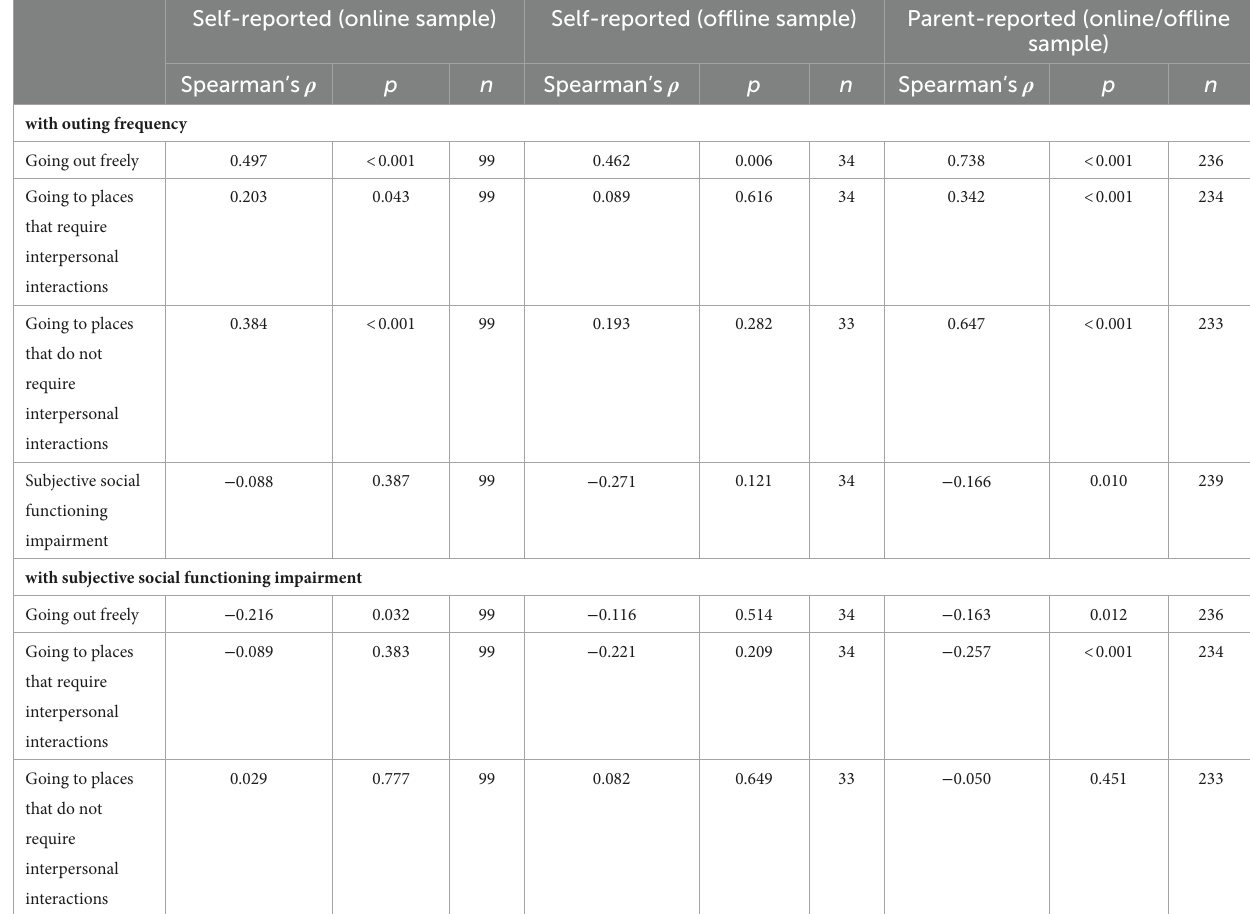
TABLE 3 Correlation of each variable with outing frequency or subjective social functioning impairment for the Hikikomori group. Self-reported (online